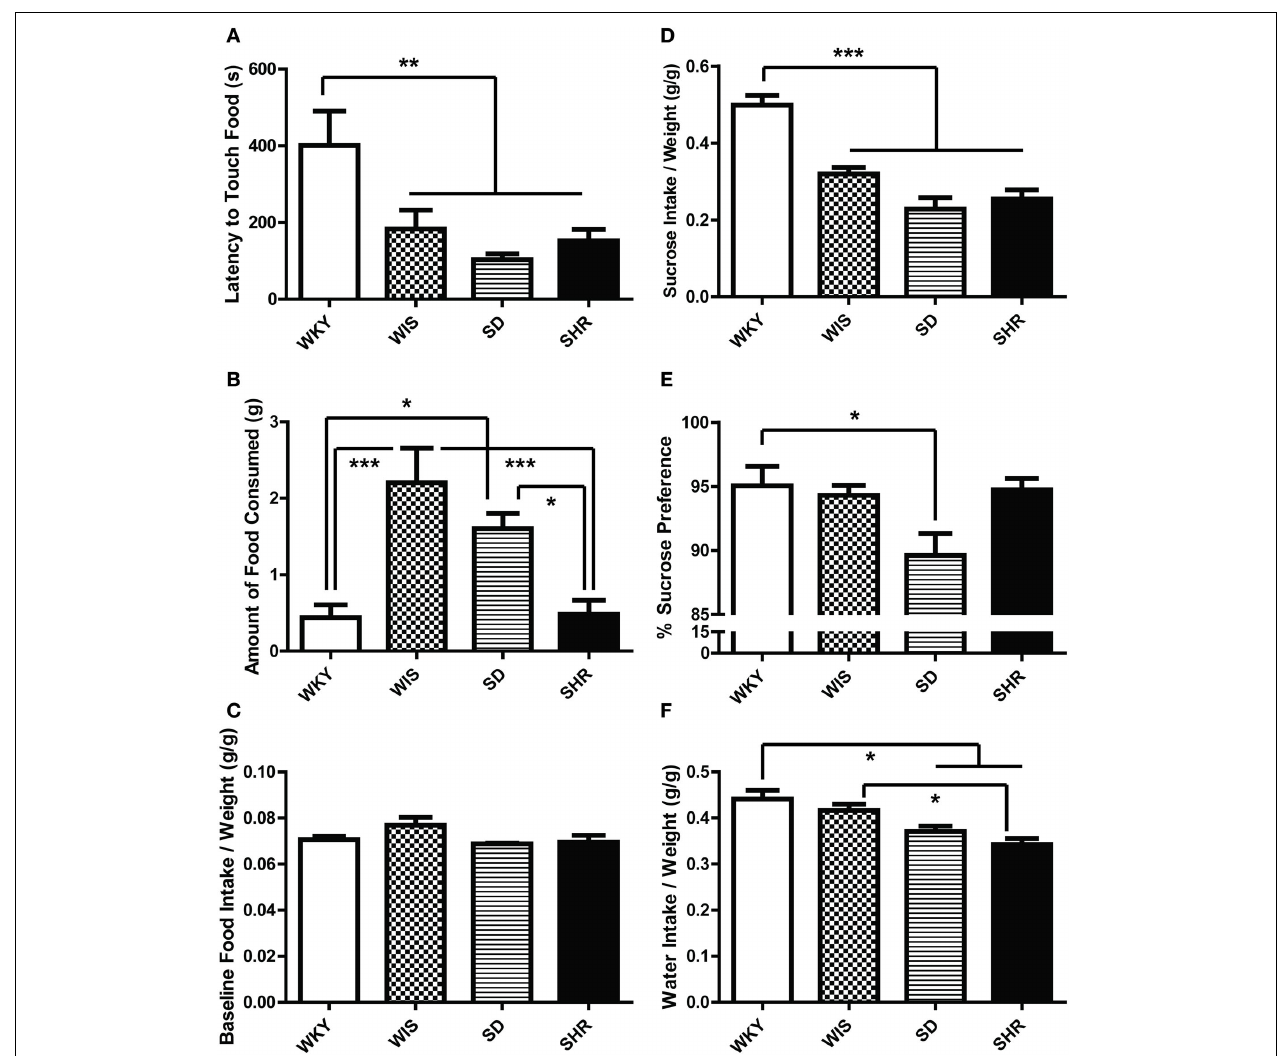
FIGURE 4 | Ingestive behavior in the novelty-suppressed feeding test and sucrose preference test. In the novelty-suppressed feeding (A–C) , WKY rats showed the greatest latency to initially touch the food pellet (A) in the 10-min test. While the SHR showed a shorter latency to touch the food compared to WKY (A) , they consumed comparably low amounts of food which were significantly less than SDs and Wistars (B) . There was no difference in the baseline food intake measured